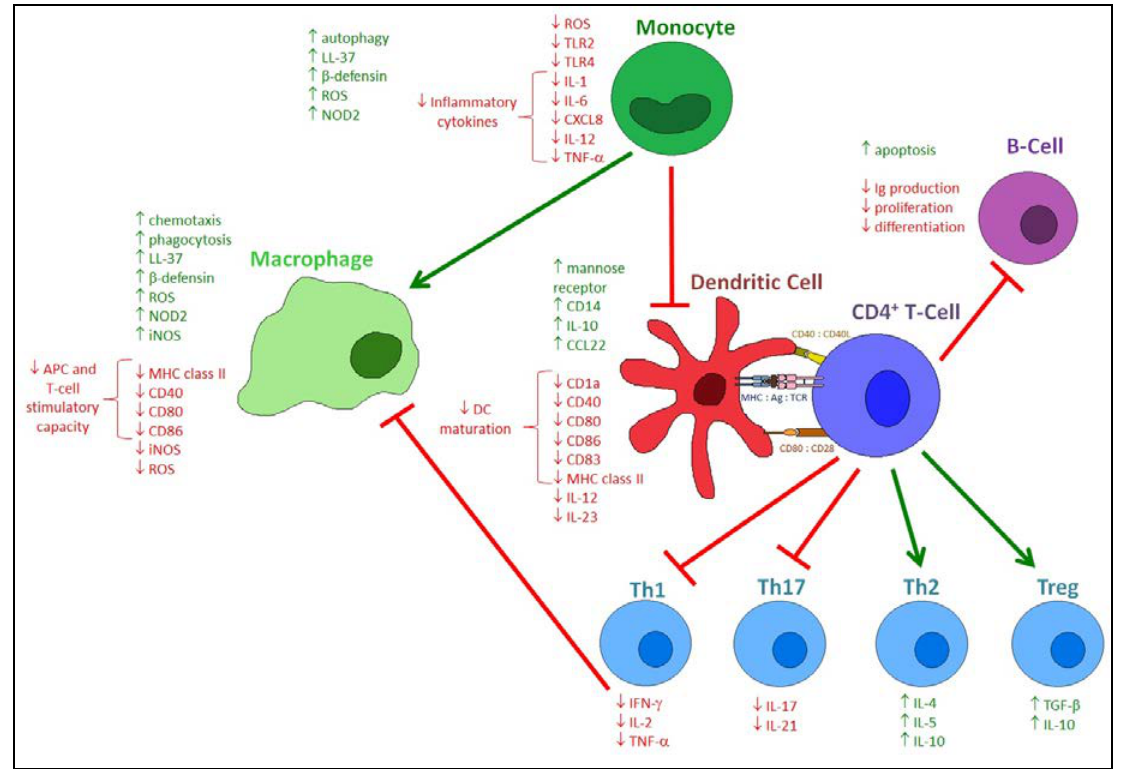
Figure 3. The immunomodulatory actions of 1,25(OH) 2 D. 1,25(OH) 2 D has diverse